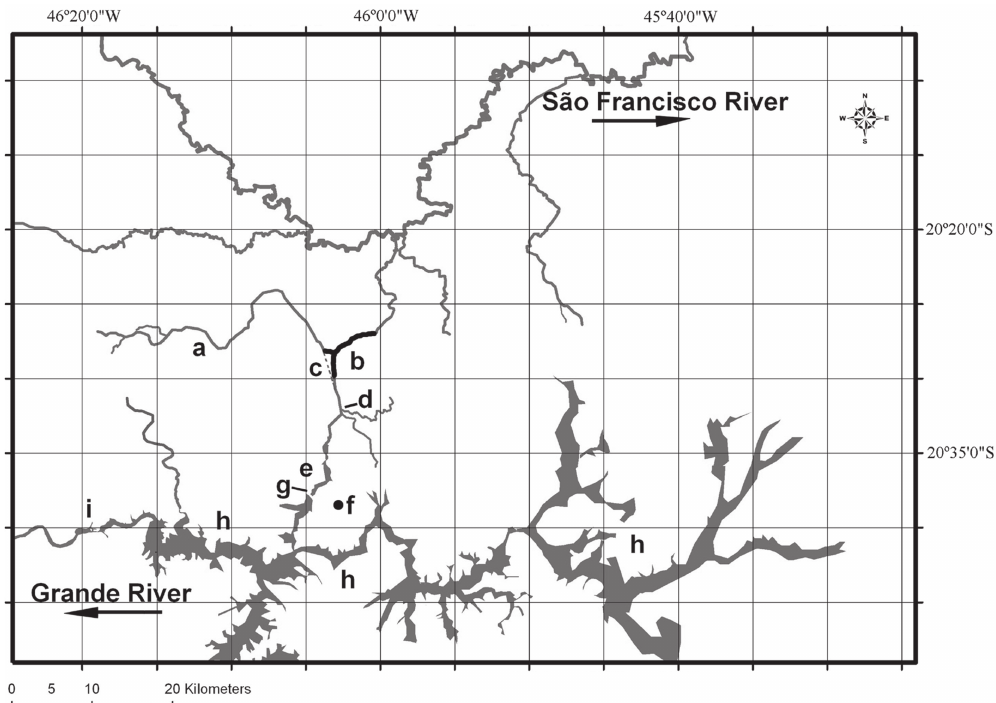
Figure 1. Transposition region of the Piumhi river: a) Piumhi River, b) transposition channel (thick black lines), c) old channel of the Piumhi River (dashed line), before the transposition, d) collection site, e) portion of Piumhi River dammed after construction of the dike near Capitólio, f) Town of Capitólio, g) Capitólio dike, h) Furnas Lake, and i) Grande river downstream from the Furnas hydroelectric